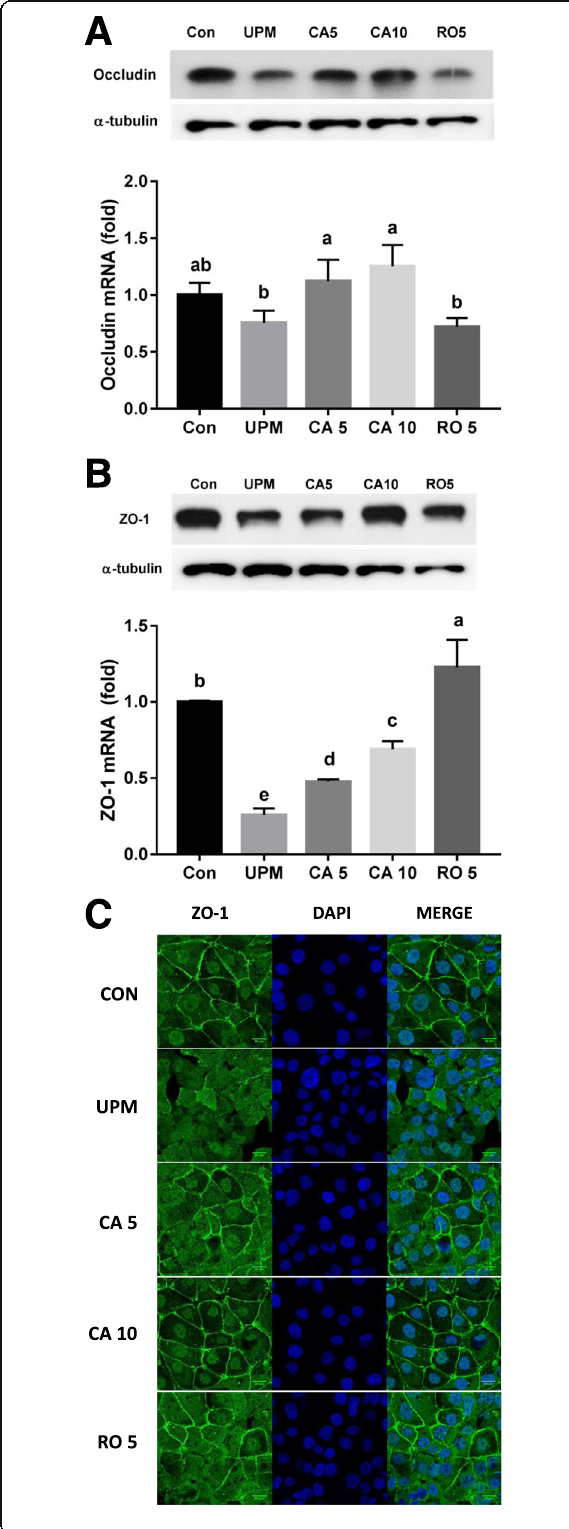
Fig. 4 Effect of CA on tight junction expression levels after exposure to UPM. Occludin ( a ) and ZO-1 ( b ) protein and mRNA expression levels in NCI-H441 cells after 24 h of pretreatment with CA (5 and 10 μ M) and treatment with UPM (100 μ g/mL) for 6 h. c Immunofluorescence staining of the effect of UPM (100 μ g/mL) and CA (5 and 10 μ M) or rotenone (RO, 5 μ M) on NCI-H441 cells. After pretreatment with CA (5 and 10 μ M) for 24 h, NCI-H441 cells were incubated with UPM (100 μ g/mL) for 6 h. Cells were preprocessed and stained with an anti-ZO-1 (1:50) antibody and DAPI (500 ng/mL). ZO-1 is indicated by the white arrow. Data are means ± SD of three experiments with triplicate samples and different letters indicate significant differences at p < 0.05 by Tukey ’ s multiple comparisons test